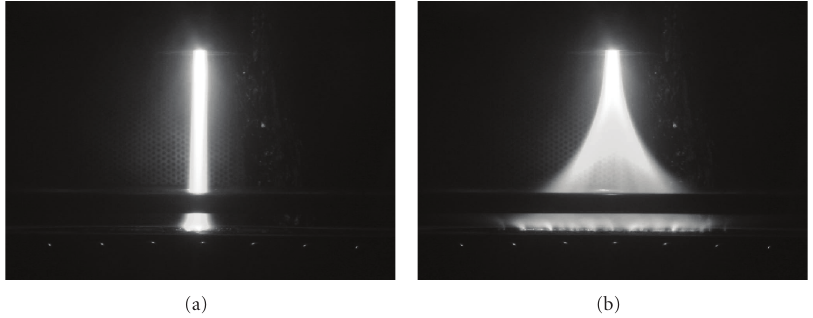
Figure 1: Typical plasma arc without magnetic field (a), and magnetically driven arc in an alternating magnetic field (b).